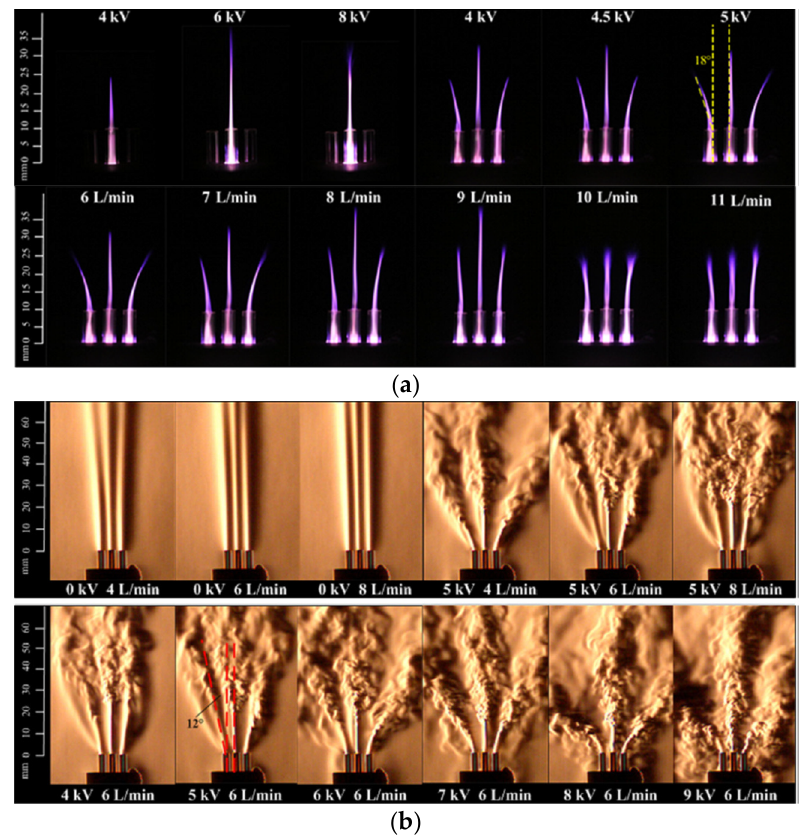
Figure 3. ( a ) Optical images of single- and three-jet arrays at different applied AC voltages and He flow rates. The jet axial separation is around 5 mm in an asymmetric cross-field APPJ setup (needle-to-ring electrodes). ( b ) Corresponding Schlieren images of the APPJ array. Divergence angles are indicated. Reprinted/adapted with permission from Ref. [23]. Copyright 2017, Authors.